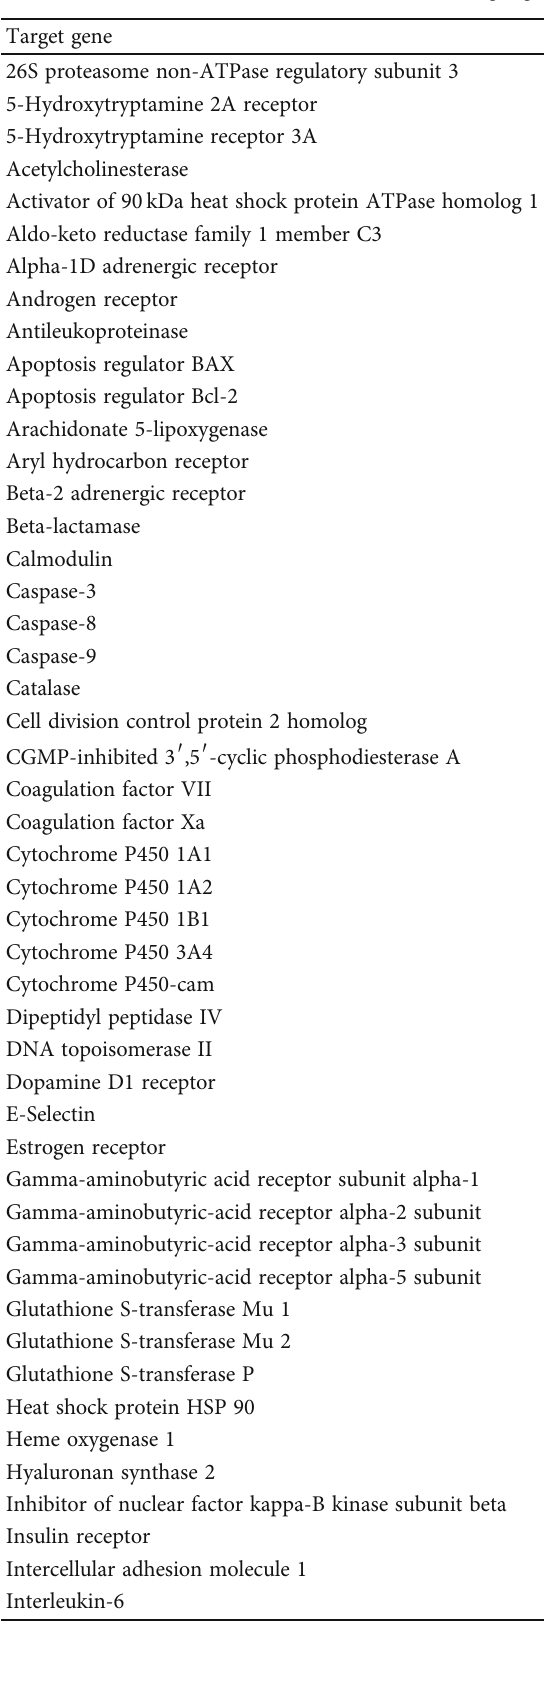
Table 2: Target-gene pairs of active ingredients of